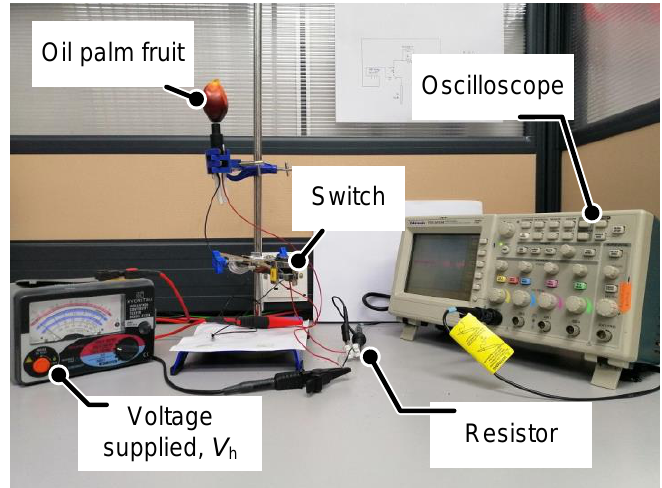
Figure 4. Experimental setup of fruit battery sensor with charging method.